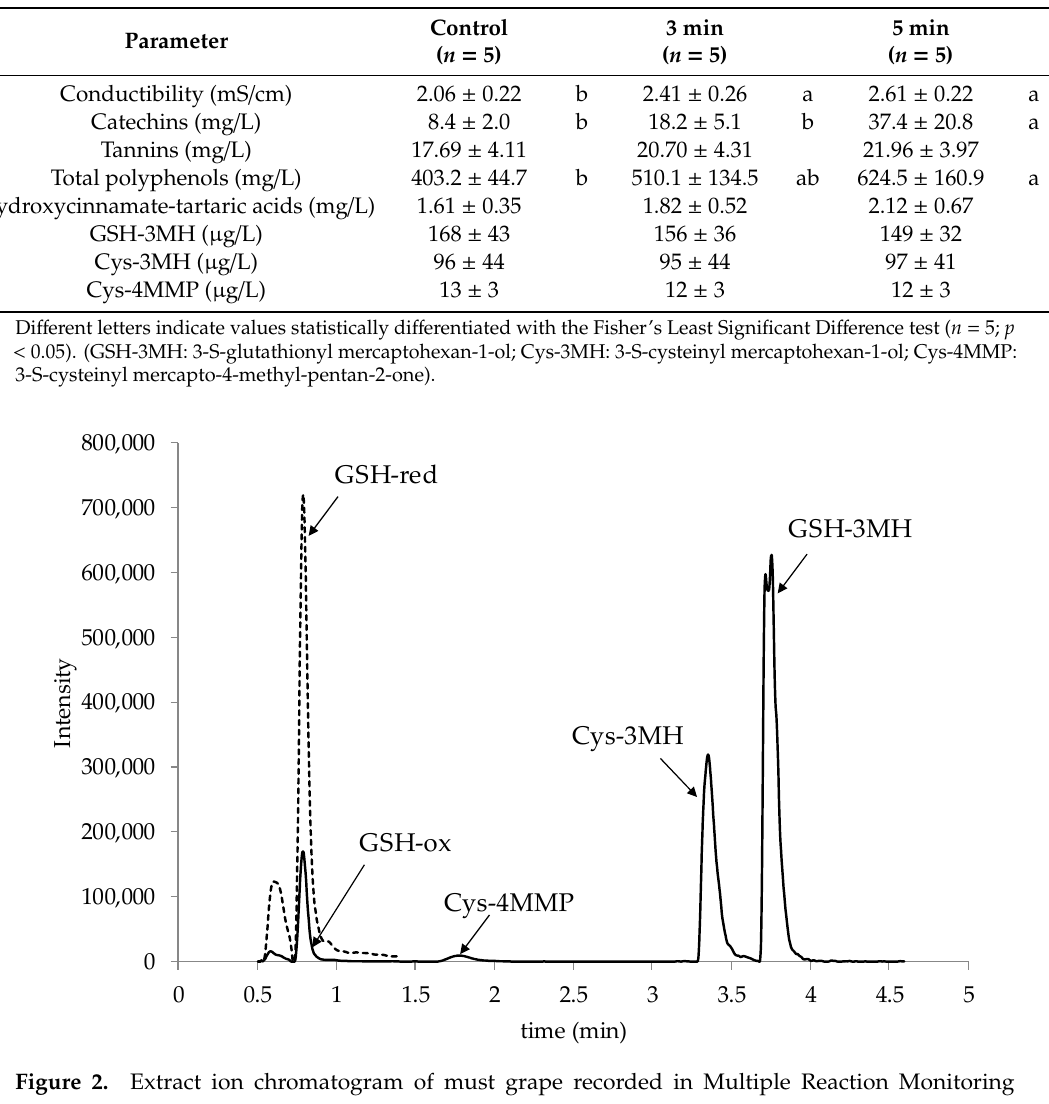
Table 2. Mean values and standard deviations of Sauvignon Blanc grape samples of the ultrasound lab-scale experiment.